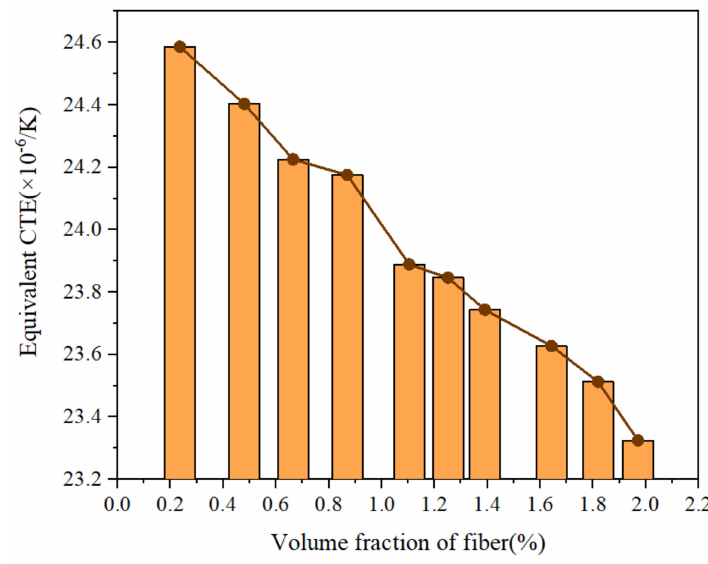
Figure 14. Trend in equivalent CTE with the variation in volume fraction of